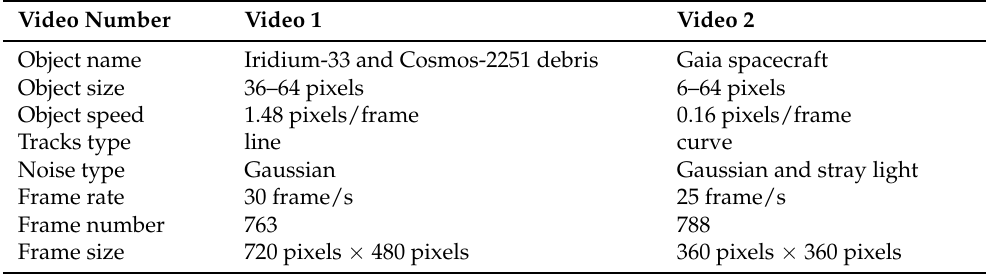
Figure 10. Example of the detected centroid on real video sequence 1 (top row) and video sequence 2 (bottom row). The detected centroid coordinates and missed detections are marked in green circles and red circles, respectively. Table 9. Details of the real video sequences of the space